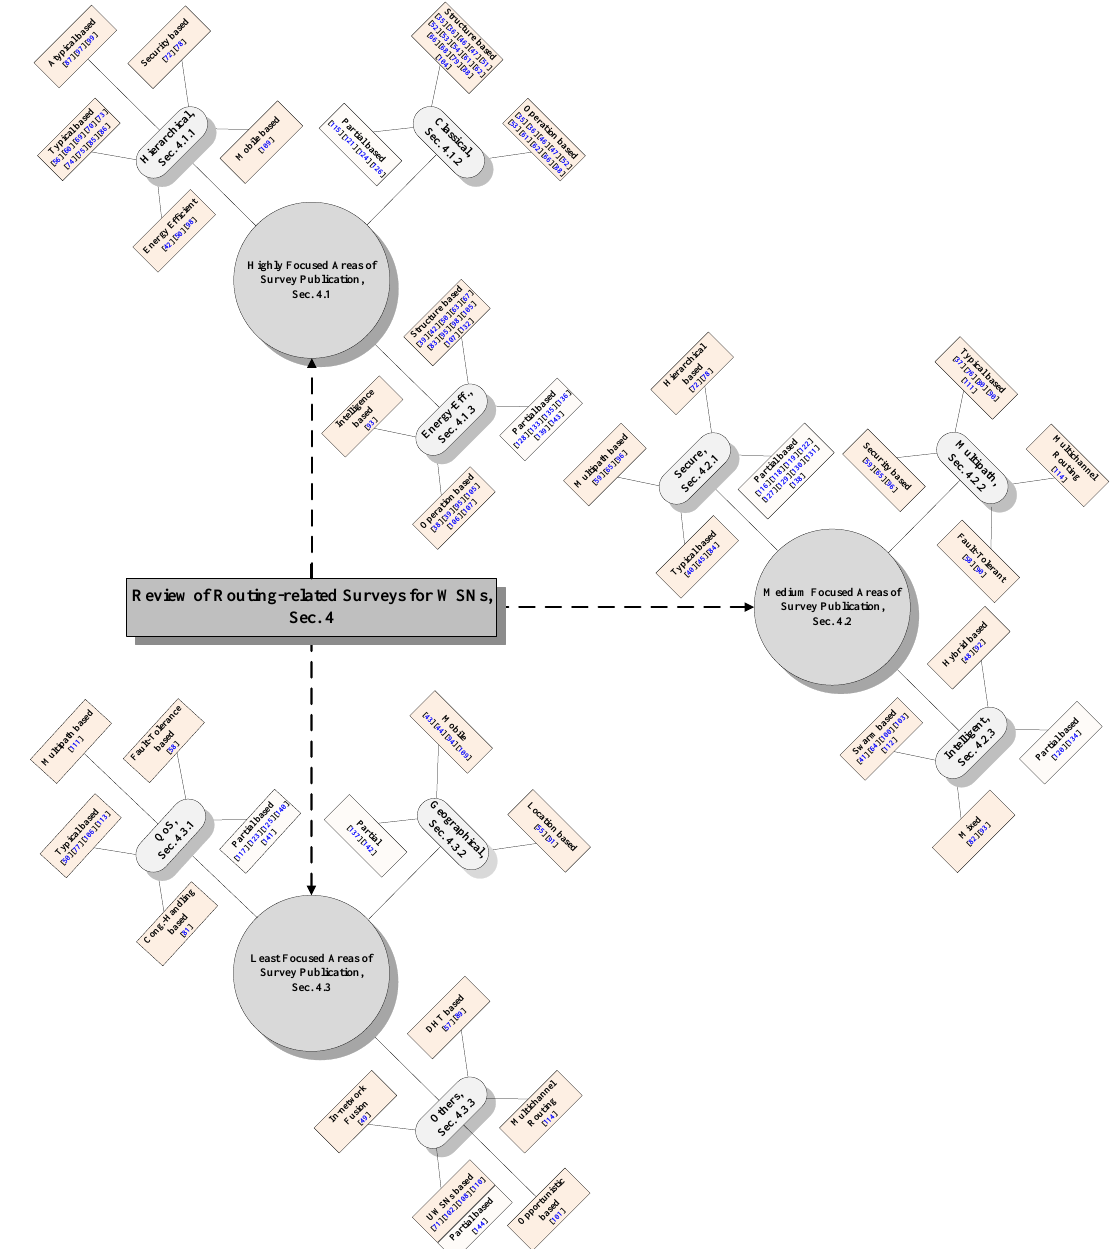
Figure 2. Classification of Routing based Surveys for